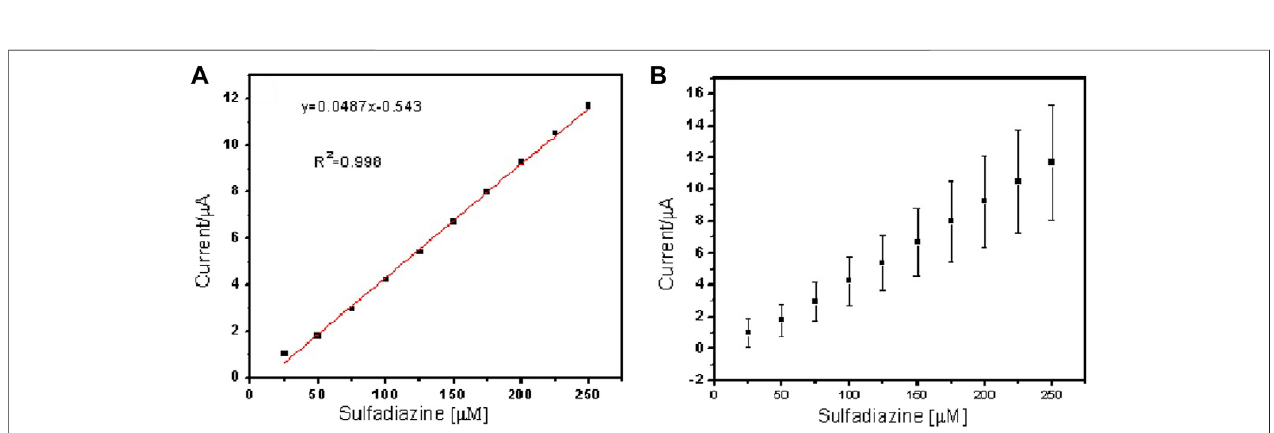
FIGURE 8 | Linear regression plot of current against concentration of sulfamethazine (A) and (B) standard error bar plot from the standard deviation ( n (cid:1) 3).